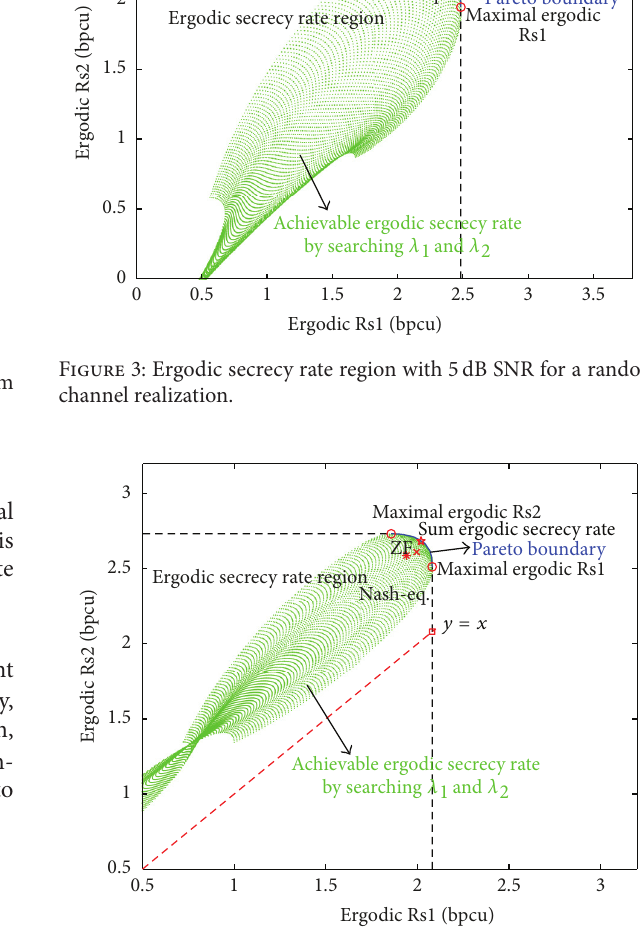
Figure 4: Ergodic secrecy rate region with 0 dB SNR for a random channel realization where the ergodic secrecy rate balancing point aligns with the single-user secrecy rate maximal